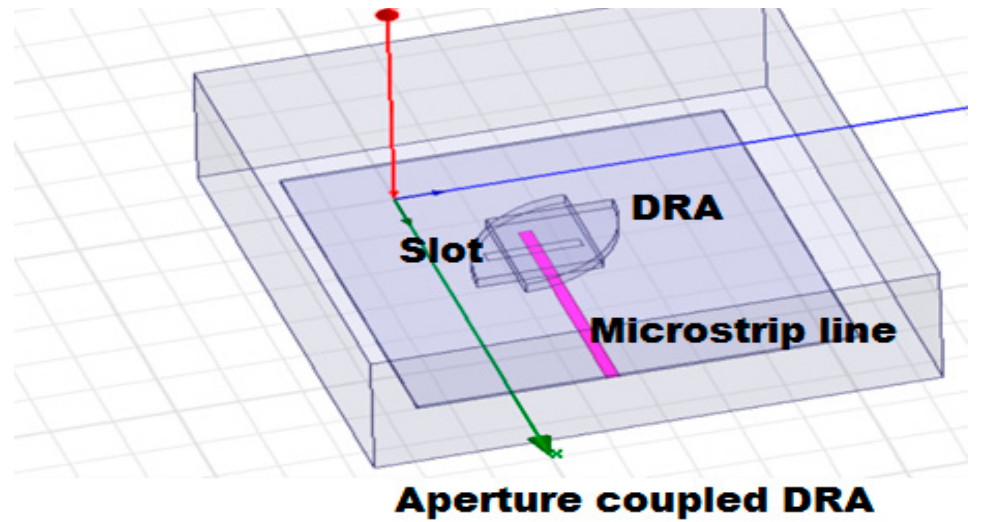
Figure 7. The hardware of 3.5 GHz aperture coupled MSDRA.